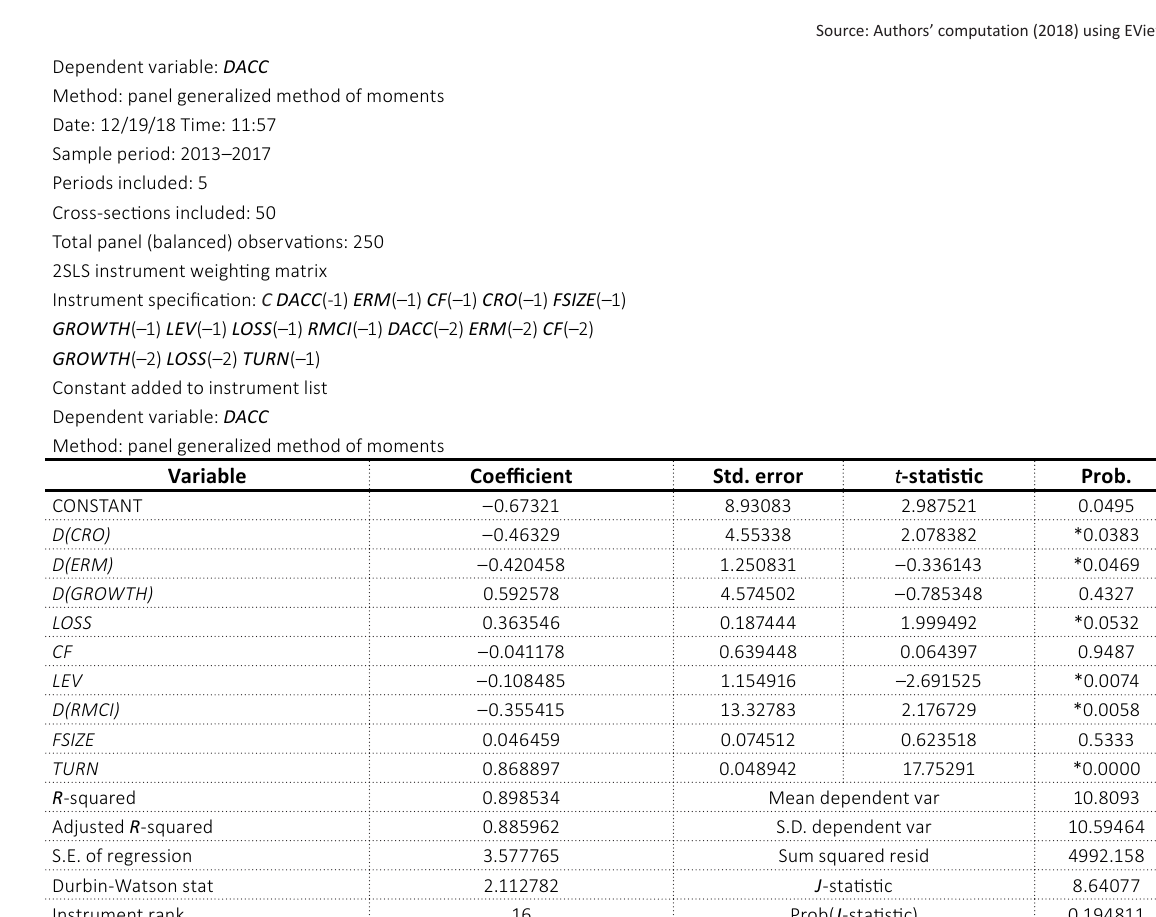
Table 5. Generalized method of moments (GMM) post-ERM period